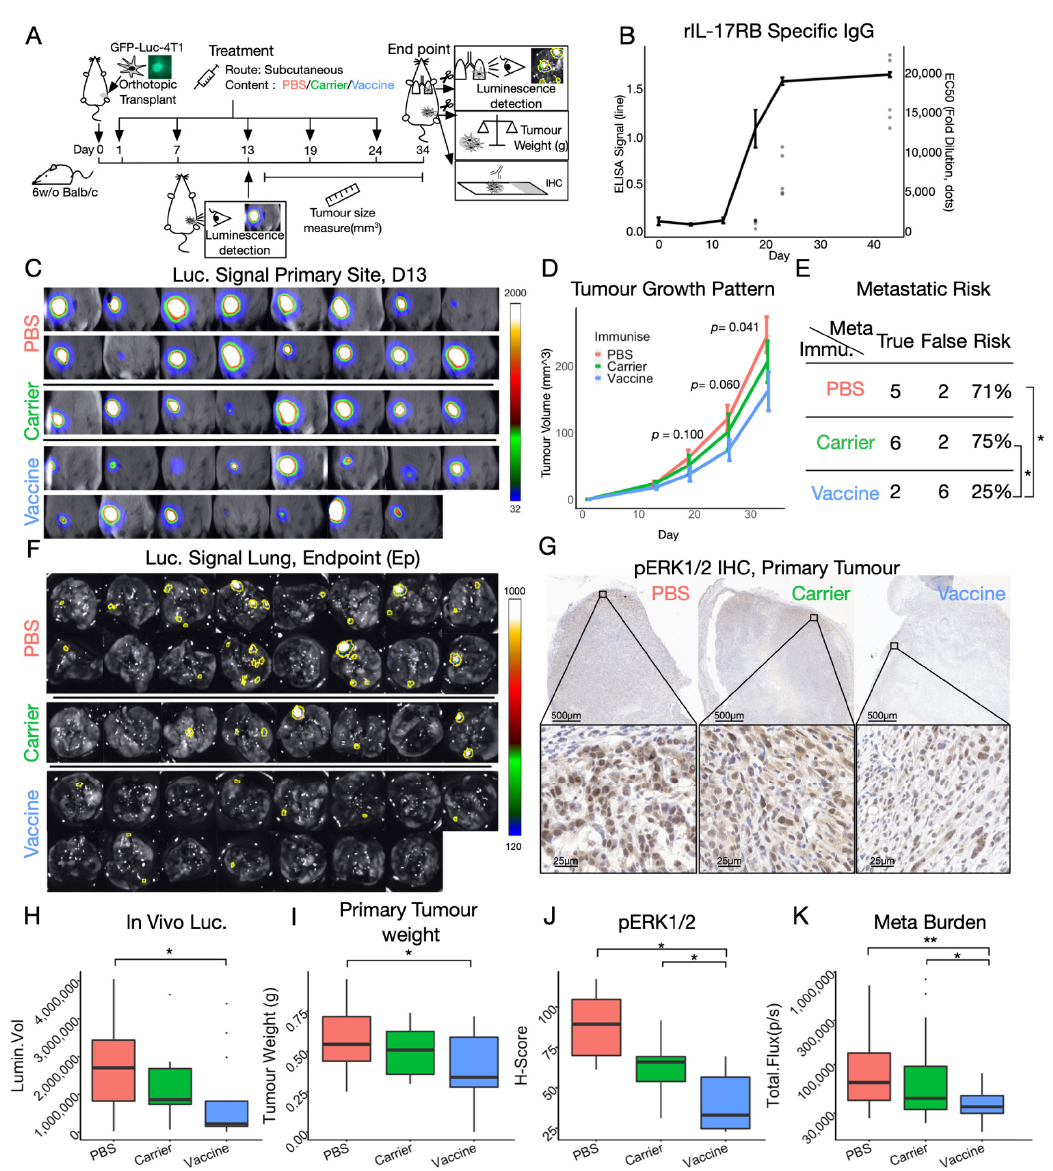
Figure 4. Therapeutic use of C:IRIS vaccine in syngeneic mouse model. ( A ) Schematics of therapeutic animal study design, schedule and data collection. Mice were separated into three treatment groups: PBS, Carrier (CRM197) and Vaccine (C:IRIS). ( B ) Immunogenicity of therapeutic vaccination scheme. BALB/c mice ( n = 5) were given C:IRIS vaccine as shown in panel A without tumor transplantation and were bled periodically to monitor their immune response. IL-17RB specific IgG response of diluted serum (625 × ) is shown in line and EC50 as dots. ( C ) Luminescence signal from primary tumors 13 days after transplantation. ( D ) Tumor growing trend in size by treatment is illustrated in different colors. A T test was done between PBS and C:IRIS vaccine (Vaccine) groups in last three observation and p value is shown on top of each observation. Error bar: mean ± SE. ( E ) Risk of distant metastasis for different treatment groups. Significance was determined with hypothesis testing on risk ratio ( F ) Luminescence signal from freshly harvested mice lung at the endpoint ( G ) representative images of immunohistochemistry (IHC) performed on primary tumor probing for activated ERK1/2 (pERK1/2) from different treatment groups. ( H ) Luminescence signal intensity of primary tumor on day 13 by treatment. ( I ) Weight of freshly harvested tumor from differently treated groups at the endpoint. ( J ) H-score on pERK1/2 in each IHC sample is plotted by treatment. ( K ) Luminescence signal intensity from lung is plotted by treatment. *: p < 0.05, **: p <